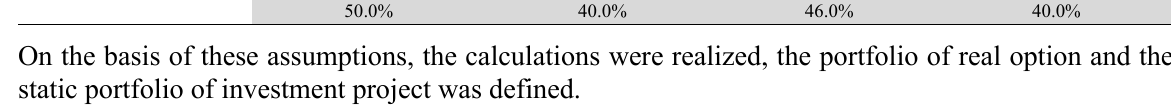
The value of the efficient real options portfolio and static NPV for the investment projects portfolio NPV average value of the static optimal investment portfolio , thousands